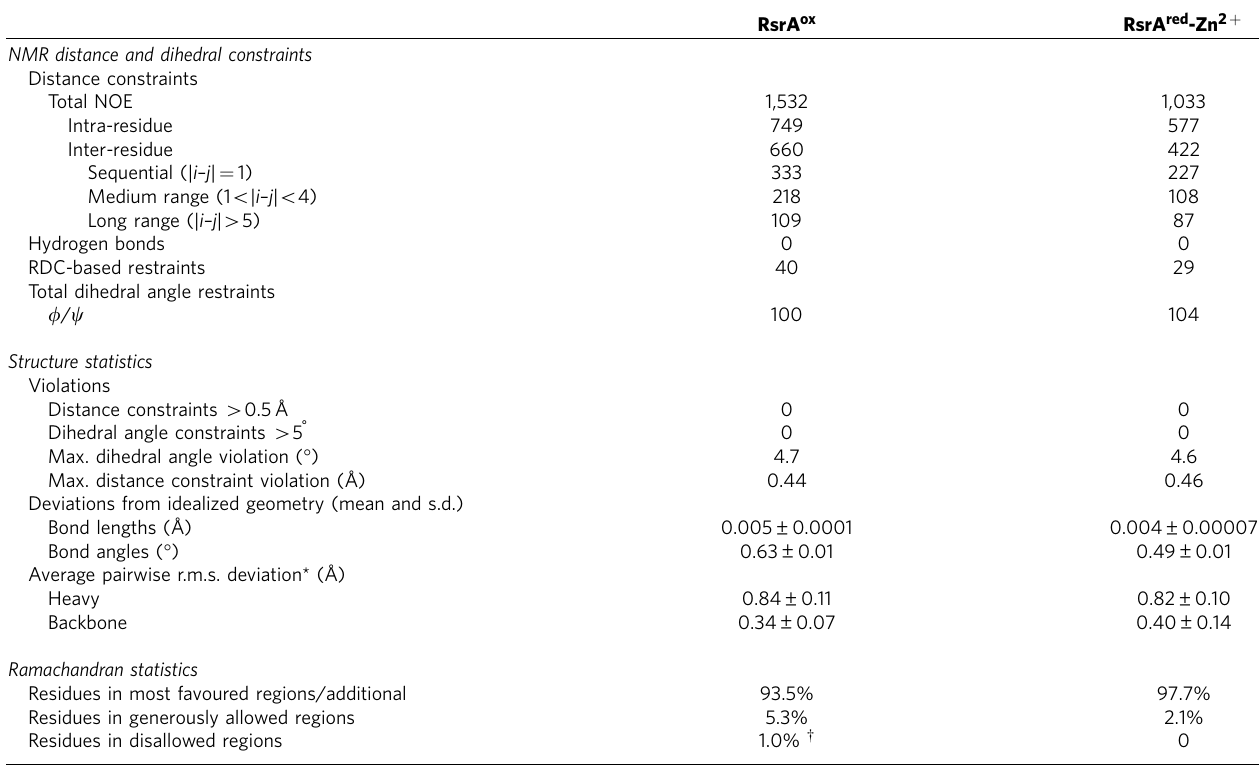
Table 1 | NMR and refinement statistics for the structures of RsrA ox and RsrA red -Zn 2 þ